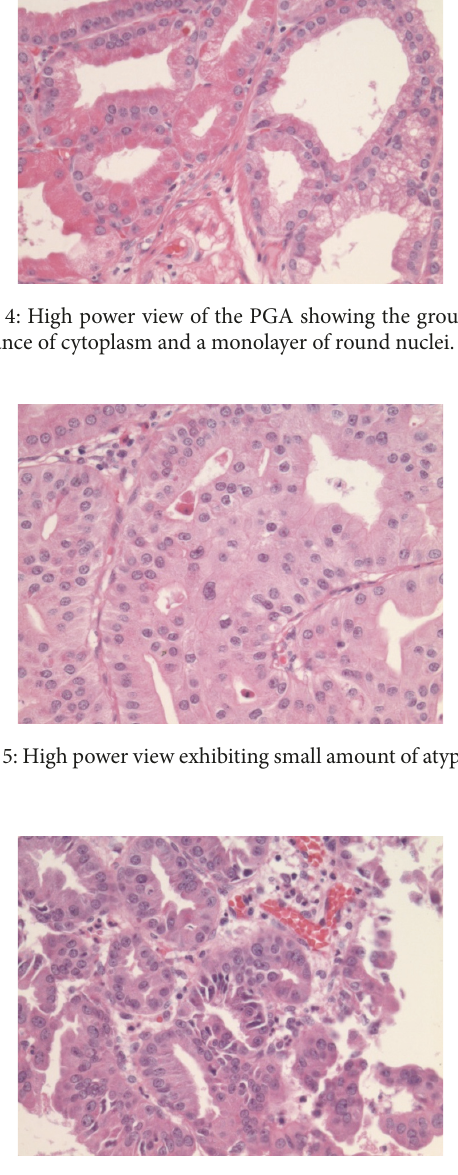
Figure 6: High power view exhibiting cell atypia including nuclear membrane irregularity and nuclear